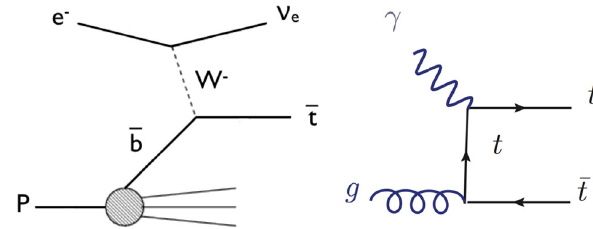
Fig. 6.8 Sample diagrams for CC DIS top quark production (left) and top quark photoproduction (right)